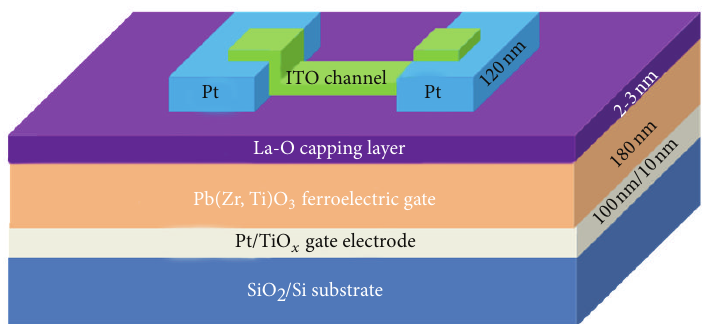
Figure 1: The cross-sectional structure of the fabricated FGT